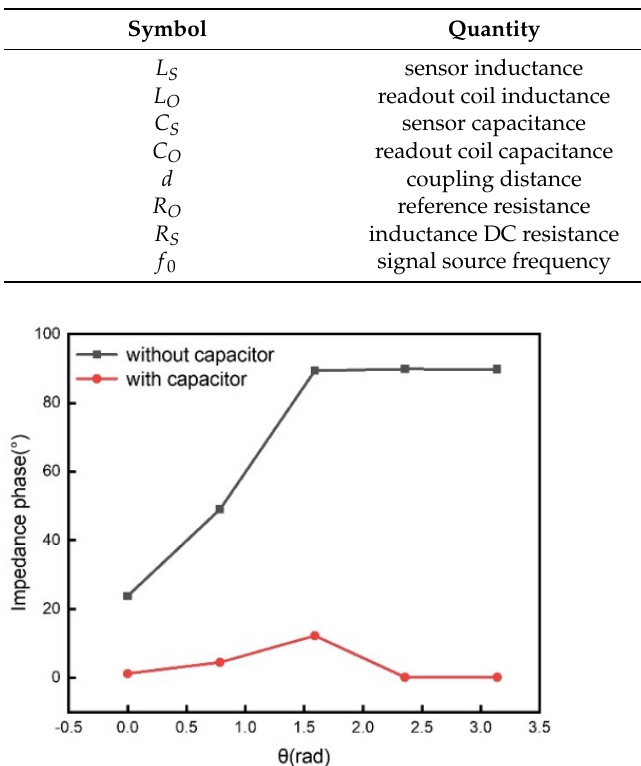
Figure 2. S chematic diagram of the ADS simulation. Figure 2. Schematic diagram of the ADS simulation. Table 2. Circuit simulation parameters. Table 2. Circuit simulation parameters.